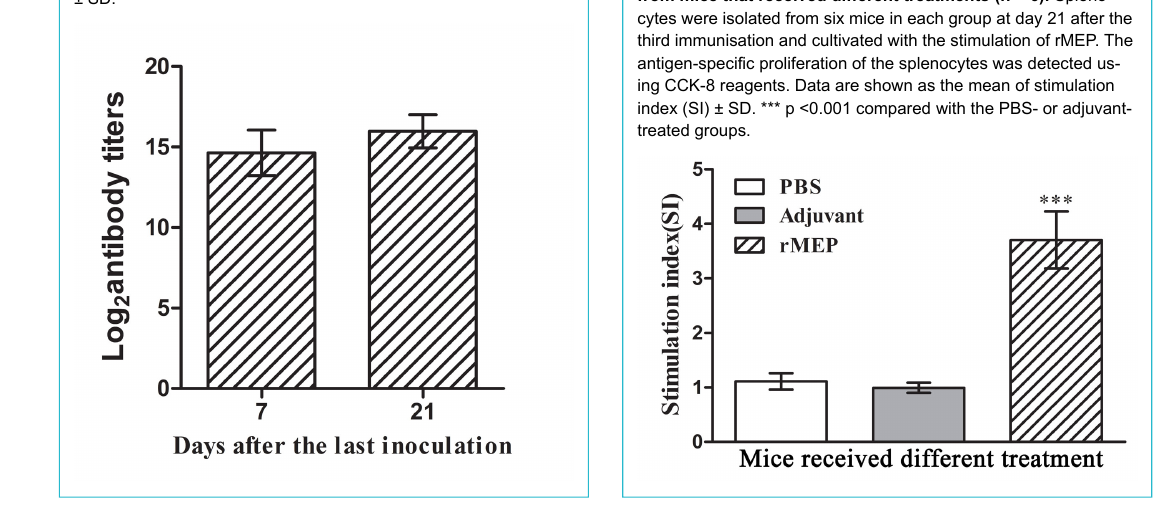
Figure 3: Antibody titres in the serum of rMEP-immunised mice (n = 6). Blood and serum samples were taken from the inner canthus of six mice at days 7 and 21 after the third immunisation. Sera were tested with indirect ELISA to assess antigen-specific antibody titres. Data are shown as the mean of log 2 antibody titres ± SD.